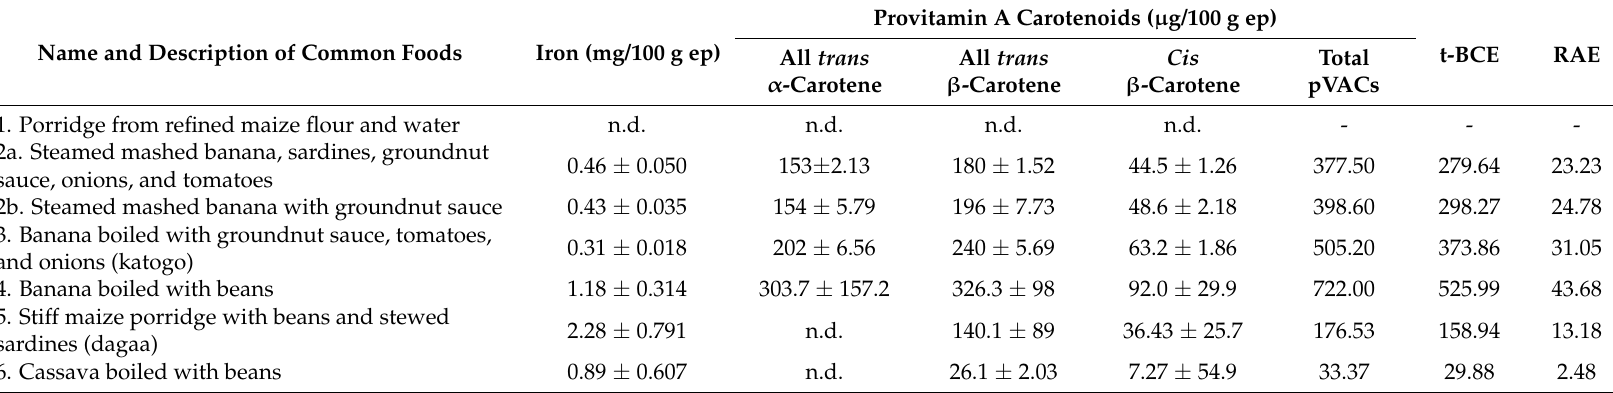
Table 3. Iron and provitamin A carotenoids content of the six common foods given to children aged 12–59 months in Northwestern Tanzania and Central Uganda.